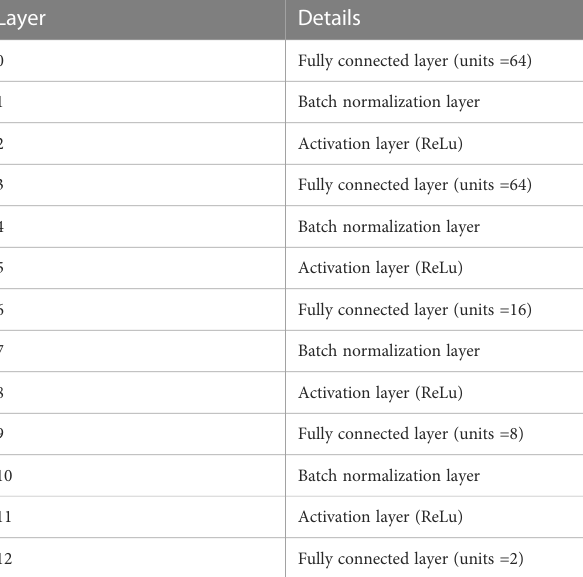
TABLE 1 The structure and parameters of DNN model.